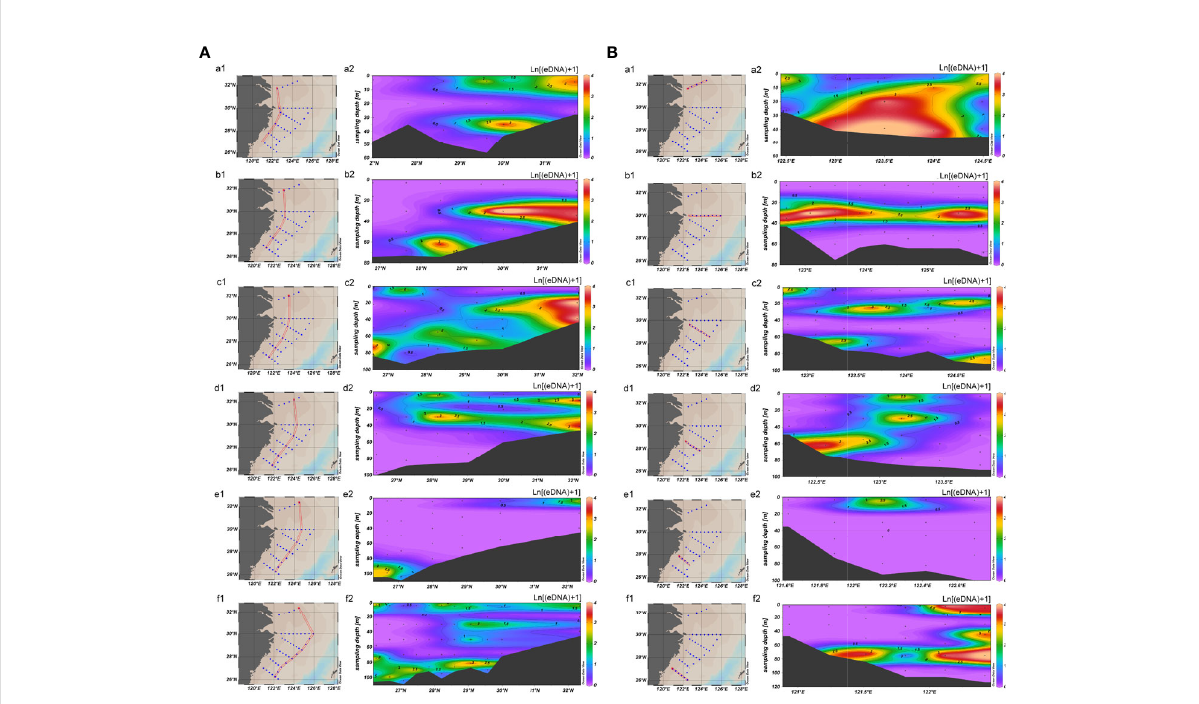
FIGURE 4 Vertical distributions of black sea bream in the East China Sea. (A) Vertical distributions of black sea bream along different longitude sections. The x-axis and the y-axis indicate the longitude and the depth, respectively. Black dots indicate sampling stations. Log transformed eDNA concentrations (copies/L) are shown with gradual colors. (B) Vertical distributions of black sea bream along different latitude sections. The x-axis and the y-axis indicate the latitude and the depth, respectively. Black dots indicate sampling stations. Concentrations of eDNA (copies/L) are shown with gradual